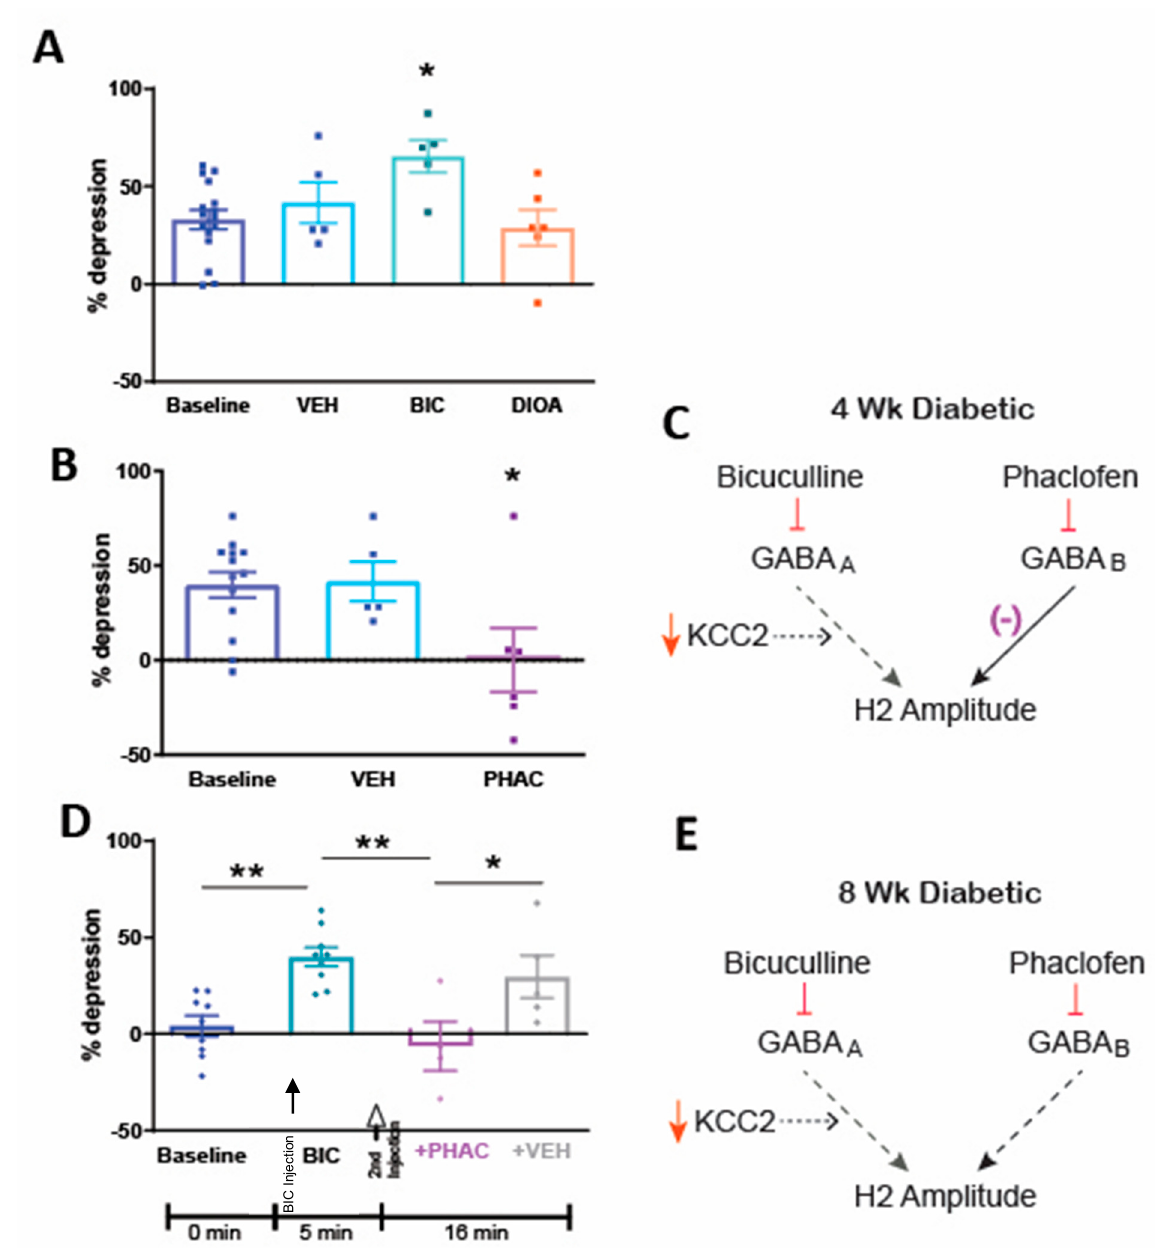
Figure 3. GABA A and GABA B receptor-mediated effects on RDD in 4- and 8-week diabetic rats. ( A ) % depression of the H-reflex in response to 1 Hz stimulation frequency in 4-week diabetic rats at baseline and 10 min after administration of vehicle, bicuculline (0.6 µg) or DIOA (3 µg). * p < 0.05 by one-way ANOVA followed by Dunnett’s post-hoc test. n = 5–16